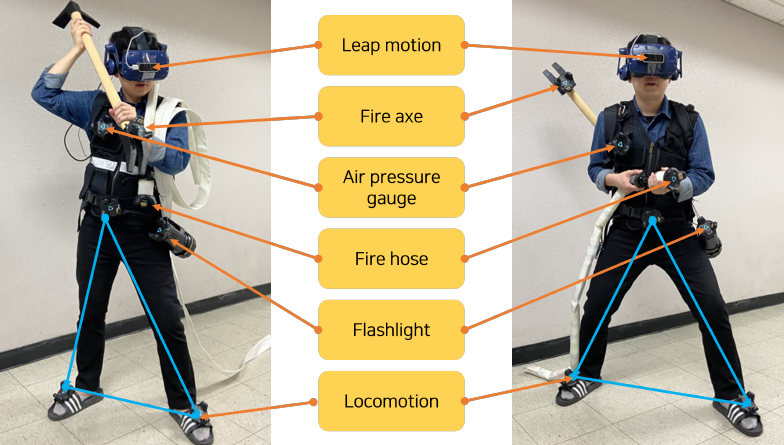
Figure 5. A participant wearing sensor devices and using real firefighting tools for the user study. Three trackers were used to support locomotion (blue lines).